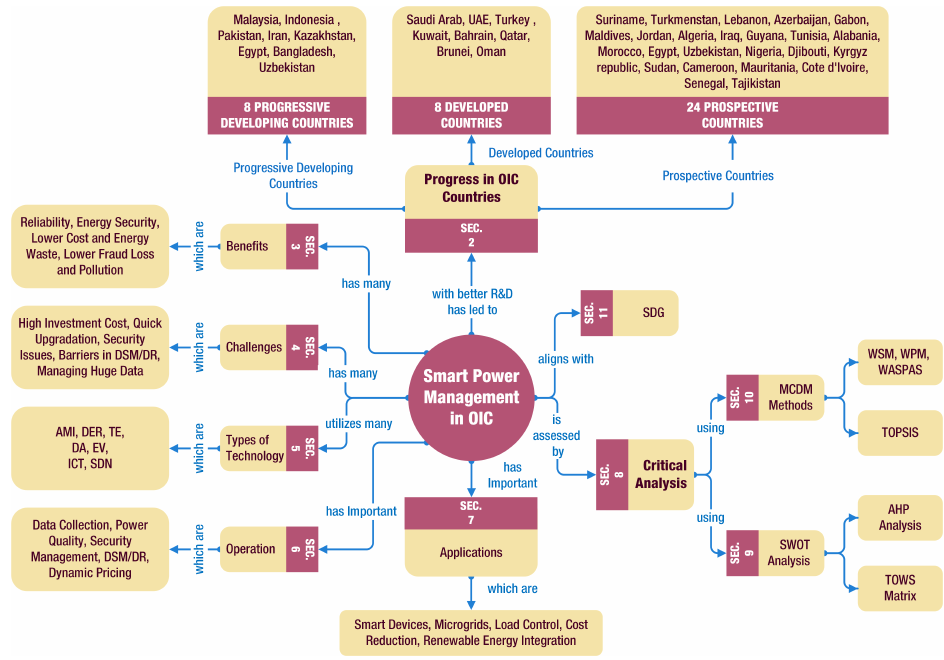
Figure 1. Structure of this paper using the concept mapping